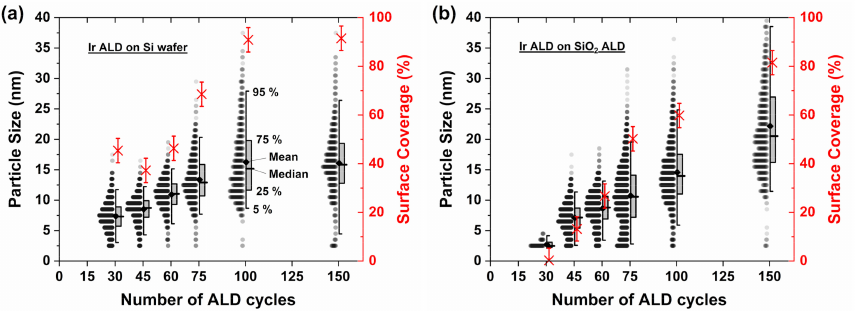
Figure 2. Particle size distribution and surface coverage of Ir coatings depending on the number of ALD cycles on ( a ) Si wafers and ( b ) SiO 2 ALD seed layers. Particle size and surface coverage were obtained from SEM images using the program ImageJ. Elements of the box plot are explained in ( a